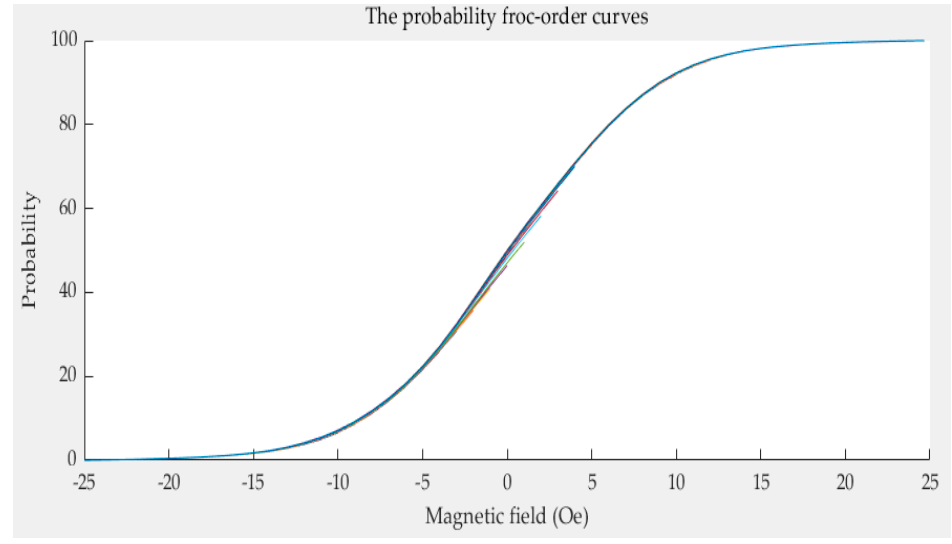
Figure 9. The first-order curves of the probability model.